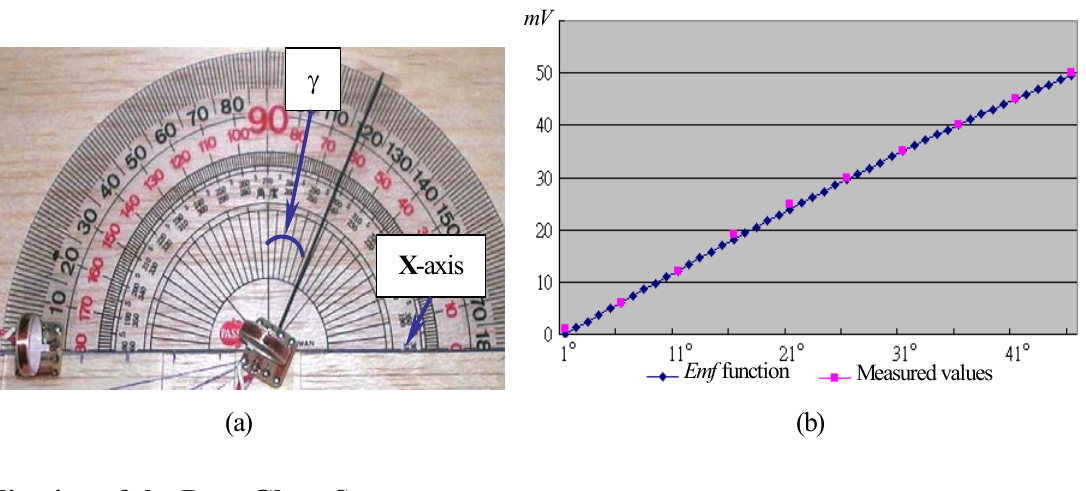
Figure 10. Illustration of a bending angle experiment: (a) the rotational angle measurement device; (b) the Emf function versus the measured